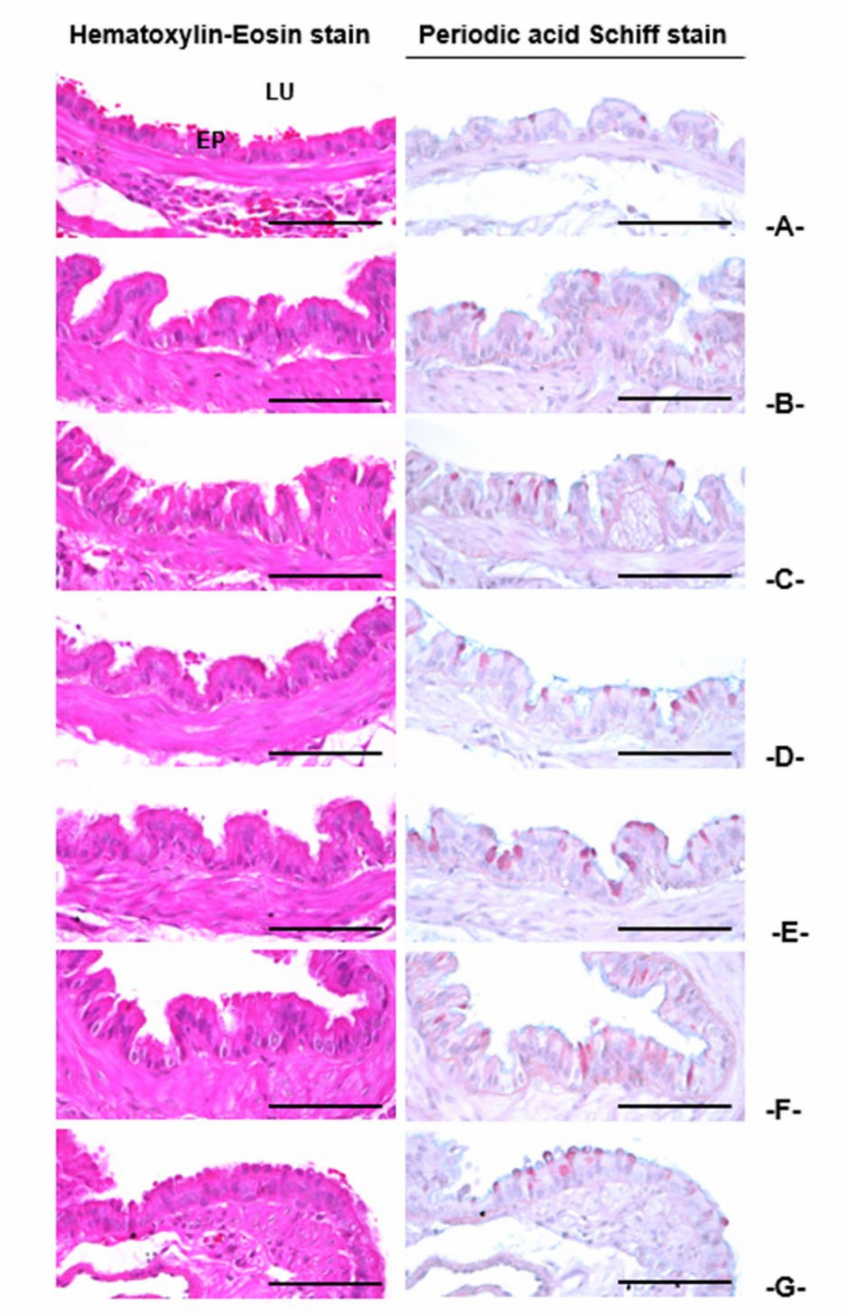
Figure 5. Changes in the histological features of intrapulmonary secondary bronchus in mice. Different treatment groups as followed by the ( A ) intact vehicle control, ( B ) AM 250 mg/kg, ( C ) AR 400 mg/kg, ( D ) KOG 400 mg/kg, ( E ) SKOG 400 mg/kg, ( F ) SKOG 200 mg/kg, ( G ) SKOG 100 mg/kg. Scale bar = 60 µ m. AM: Ambroxol; EP: Epithelium; LU: Lumen; PAS: Periodic Acid Schiff